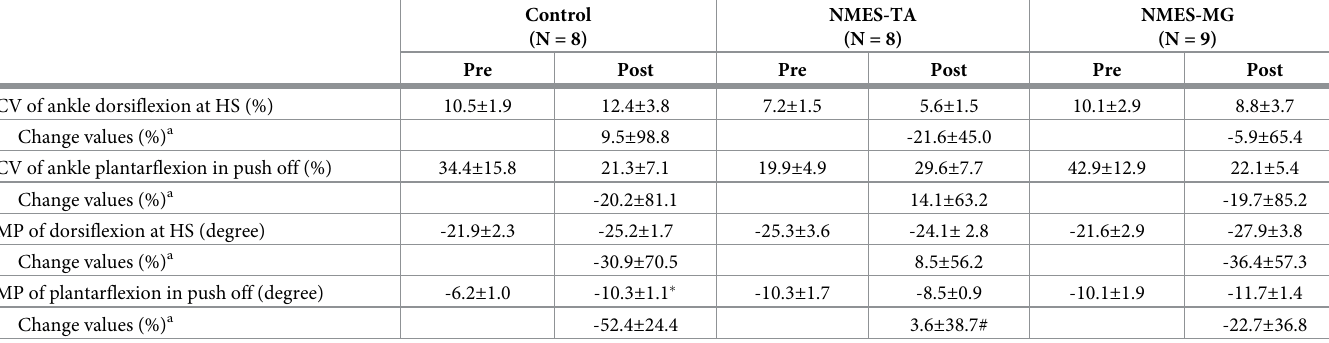
Table 5. The active range of motion of the ankle joint during gait before and after training in 3